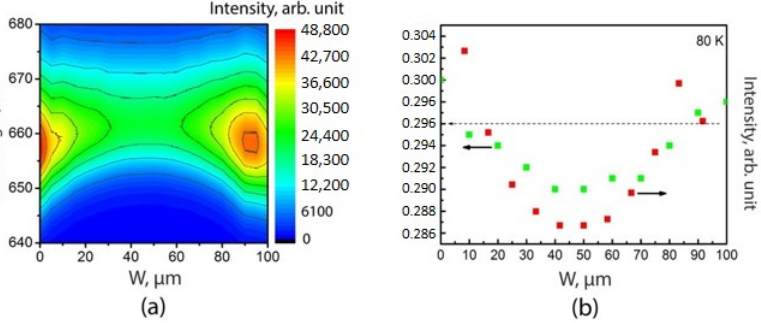
Figure 8. ( a ) μ -PL spectra map measured at 80 K for Al x Ga 1-x As upper cladding layer for the SAE- ML-W sample. ( b ) Al mole fraction and μ -PL spectra intensity as functions of the measurement position in the window obtained from the PL spectra map. The dashed line corresponds to the Al mole fraction for the AlGaAs layer of StE sample. Green dot—composition, red dot—intensity.